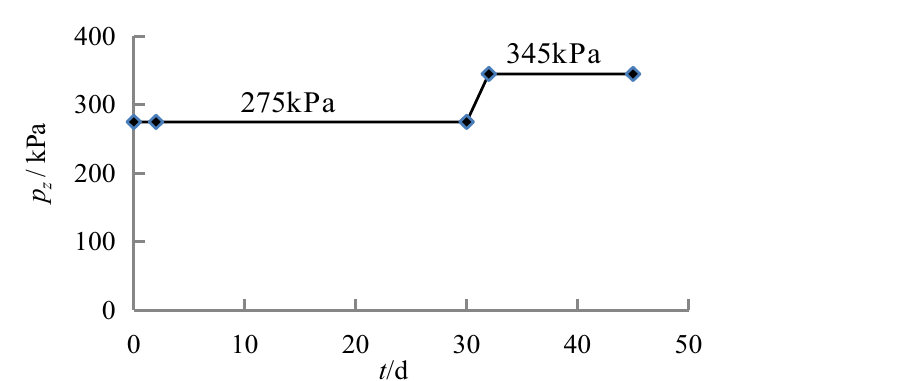
Figure 6. Loading process of the caisson in Sections